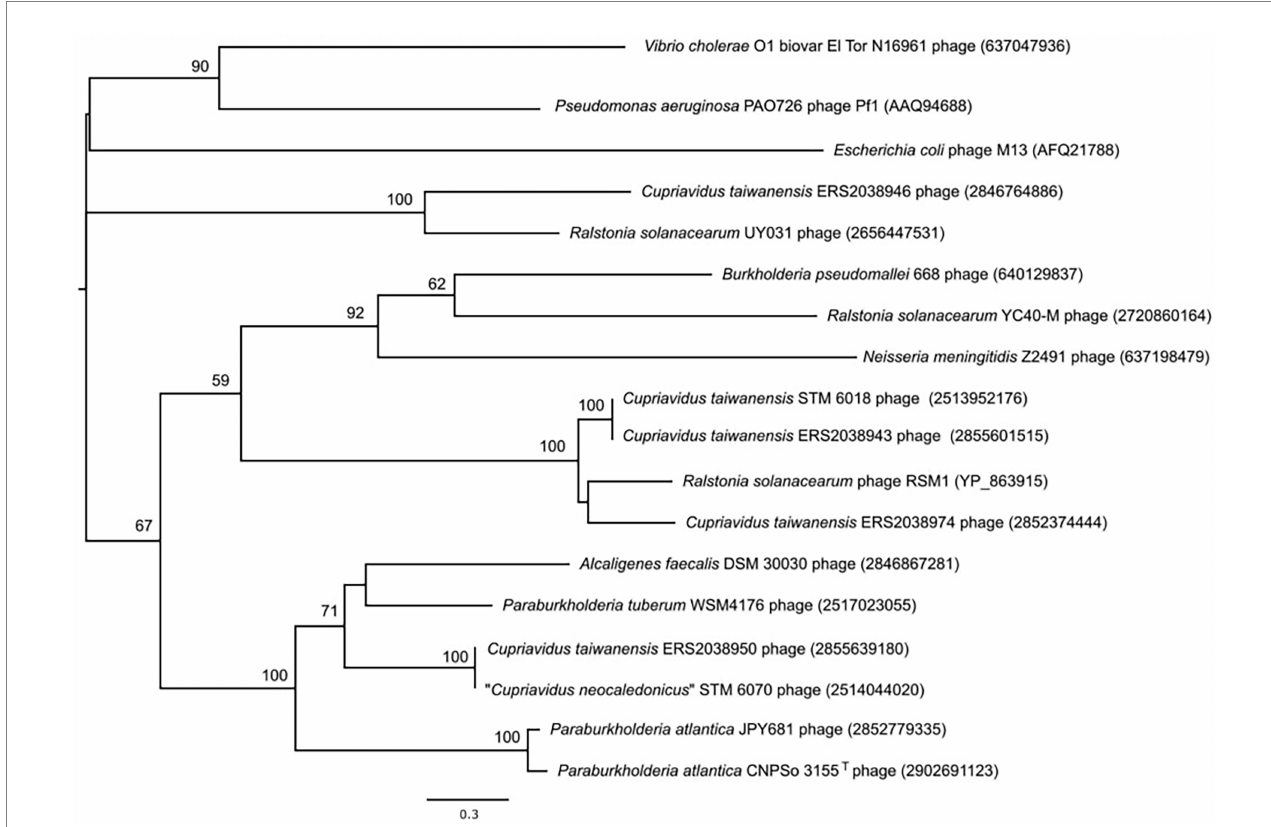
FIGURE 5 Phylogenetic tree based on the amino acid sequences of pI (zonula occludens toxin) proteins of filamentous phages from the genomes of Cupriavidus taiwanensis STM 6018 and diverse bacterial animal and plant pathogens, symbionts, and environmental strains. NCBI and IMG accession numbers are given in parenthesis. A total of 547 amino acid positions were used to reconstruct the tree. The evolutionary history was inferred by using the Maximum Likelihood method and a discrete Gamma distribution was used to model evolutionary rate differences among sites. Human pathogens, or potentially pathogenic species in the tree include Burkholderia pseudomallei , Escherichia coli , Neisseria meningitidis , Pseudomonas aeruginosa and Vibrio cholerae ; Ralstonia solanacearum is a plant pathogen; the Cupriavidus and Paraburkholderia spp. are rhizobial symbionts; and Alcaligenes faecalis is an environmental